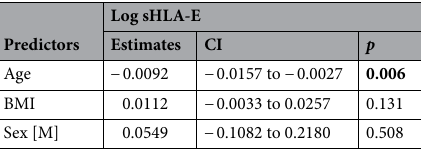
Table 2. Linear logistic regression. Bold value indicates statistically significant. Adjusted R 2 /0.034/0.024. CI confidence interval, p p